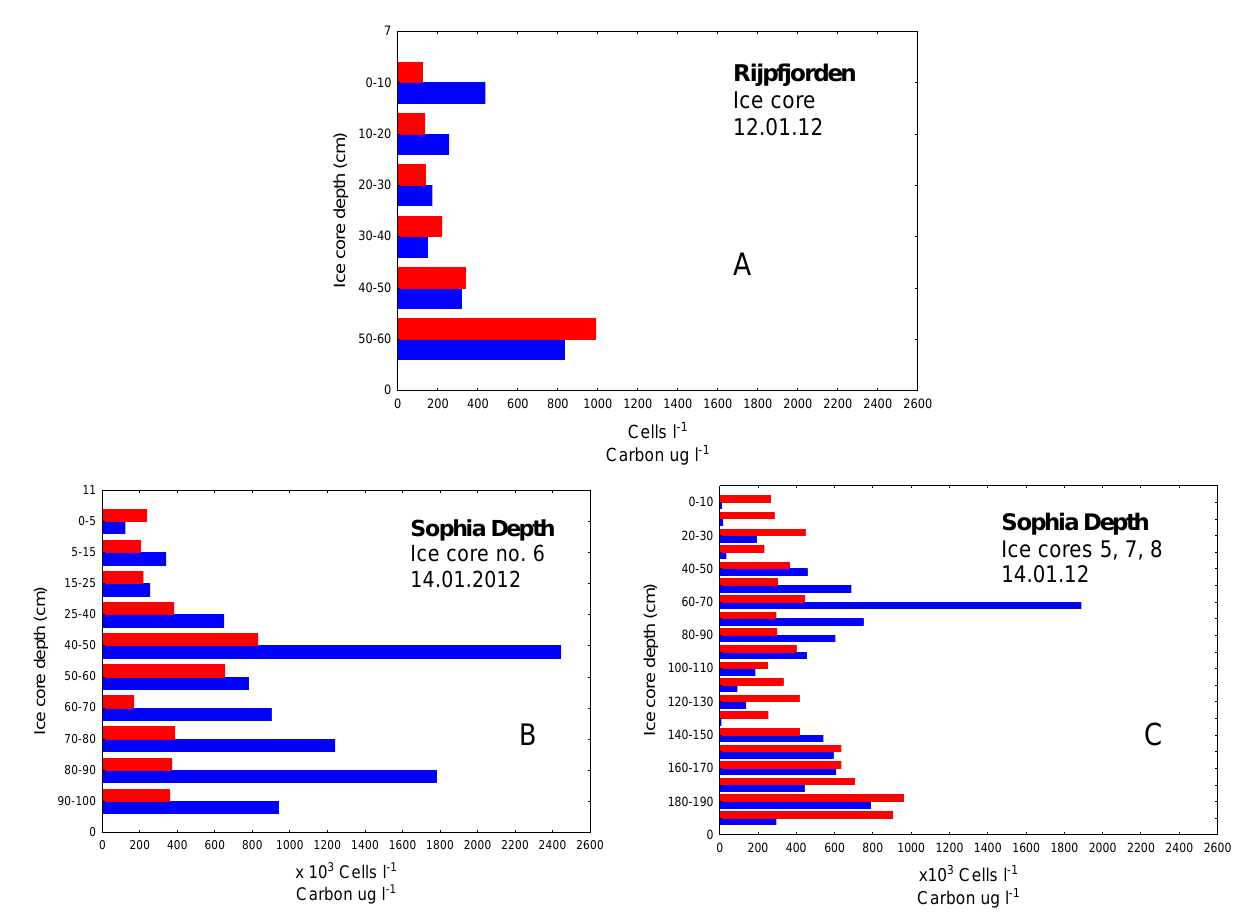
Figure 3. Vertical distribution of cells (×10 3 L −1 ) and organic carbon (µg L −1 ) in ice cores from Rijpfjorden ( A ) and the northern Barents Sea (Sophia Depth, B and C ) pack ice in January. The 1986 April cruise took place over the Hopen Depth and the western slope of the Central Bank. Northerly winds had pushed the ice south to 75 ◦ N. The ice cover was dense, and under-ice irradiance was low (Table 1). Chlorophyll in this ice was fairly high, max 17.7 mg m 2 . The outer zone had thinner ice (20–40 cm), and several pelagic algal species were found (particularly Thalassiosira and Chaetoceros species). Further in, pelagic species still prevailed ( Chaetoceros gelidus , C. wighamii , Thalassiosira nordenskioeldii , Navicula vanhoeffenii ) together with several more algal species that thrive well in both ice and water ( Porosira glacialis , Shinodisus bioculatus , Fragilariopsis oceanica , N. kariana , N. pelagica , Entomoneis sp.). The thicker ice was dominated by the typical ice algae Nitzschia frigida with epiphytes likes Pseudogomphonema arcticum , Attheya septentrionalis, and Synedropsis hyperborea (Table 2).